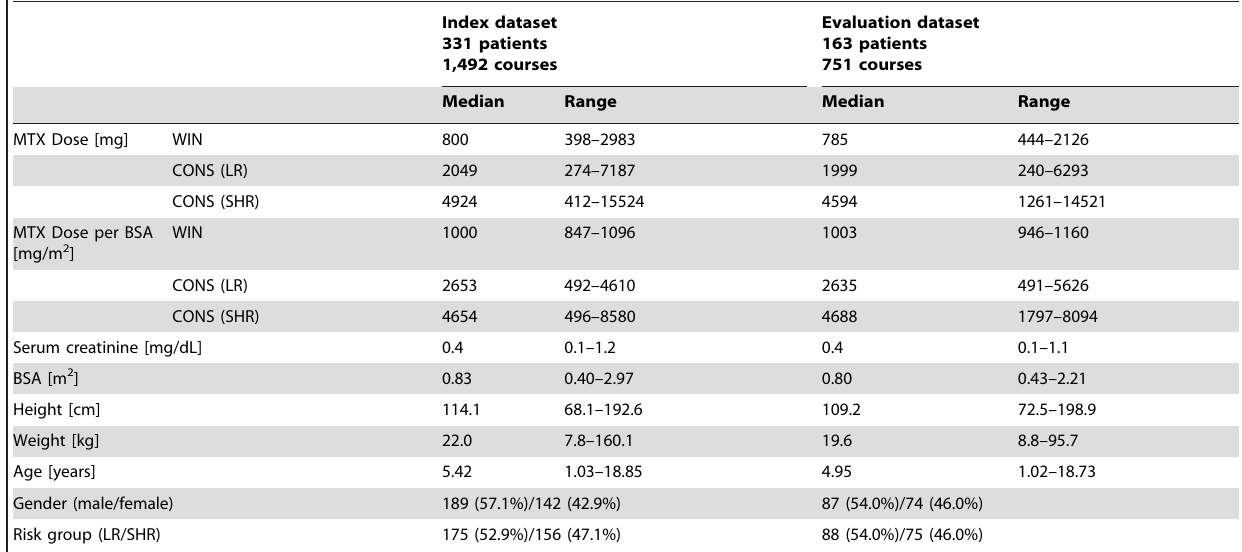
Table 1. Patients characteristics.